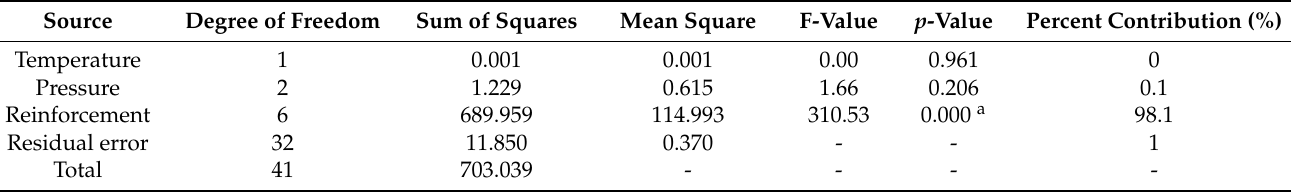
Table 6. Analysis of variance for S/N ratios of weight loss.